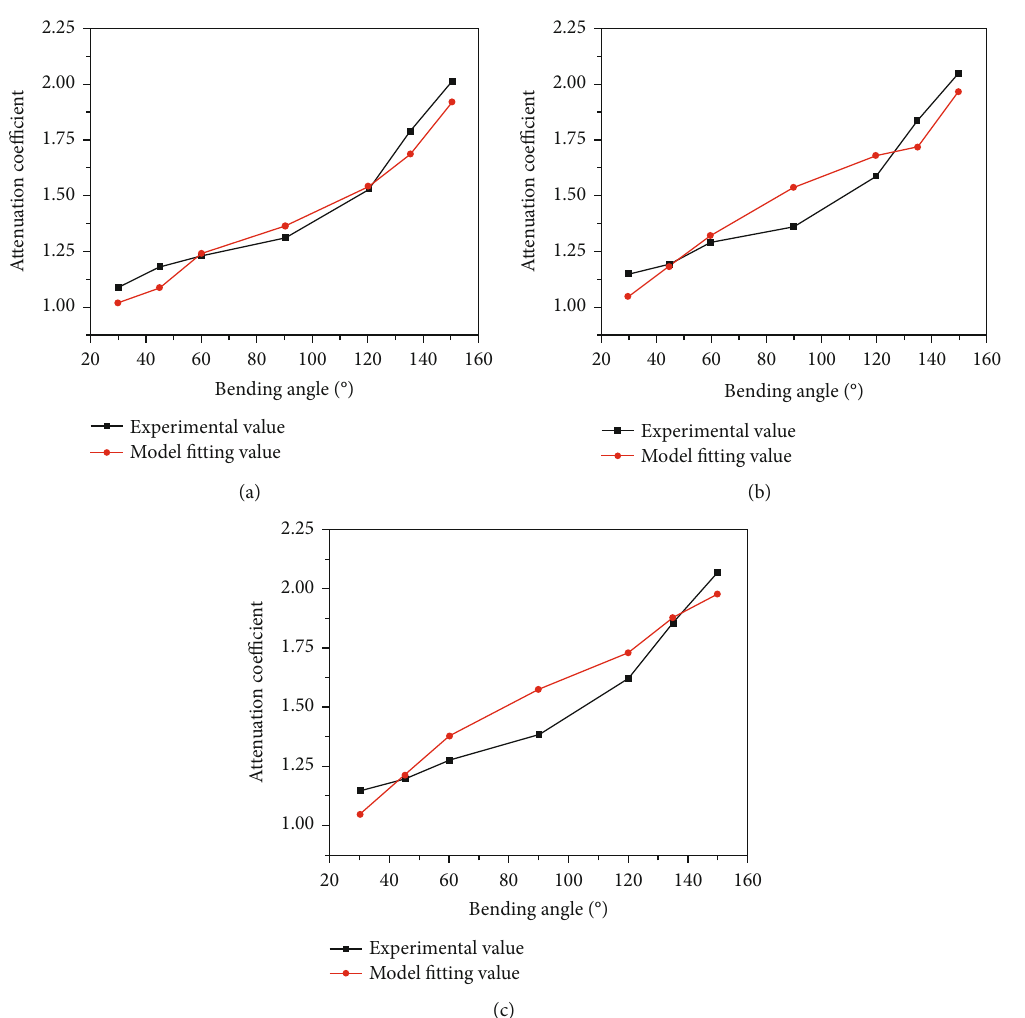
Figure 7: Comparisons of the experimental value and model fi tting value of attenuation coe ffi cient: (a) 0.23m 3 gas volume, (b) 0.28m 3 gas volume, and (c) 0.31m 3 gas